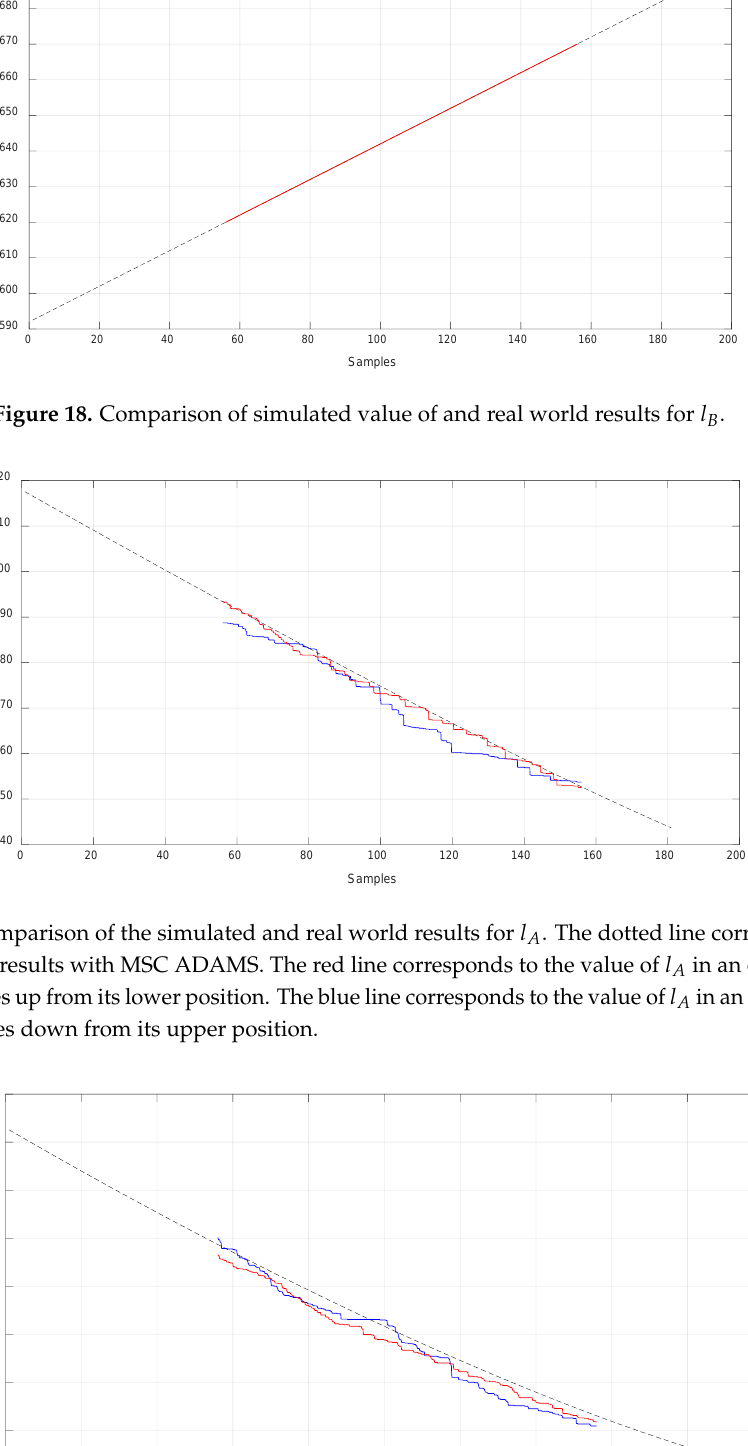
Figure 20. Comparison of the simulated and real world results for l D . The red line corresponds to the value of l D in an experiment where EE 2 goes up from its lower position. The blue line corresponds to the value of l D in an experiment where EE 2 goes down from its upper